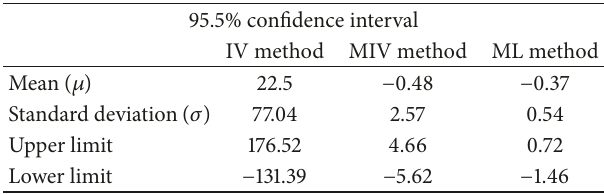
Table 4: Confidence interval calculated for the IV and MIV methods. The calculations use 𝜇 ± 2𝜎 to get the upper and lower bounds of the 95.5% confidence interval.